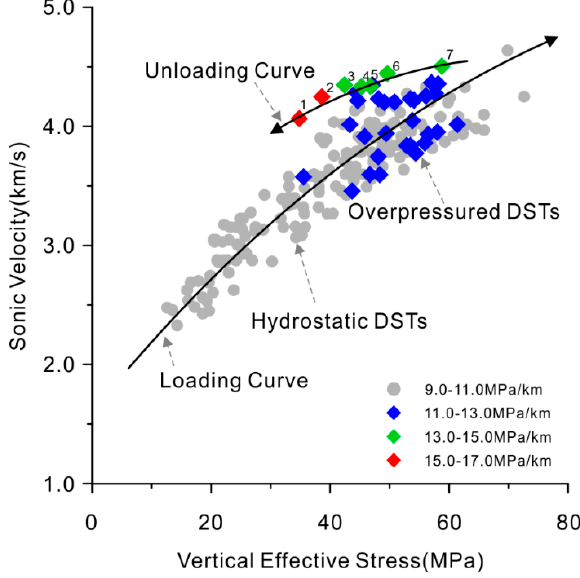
Figure 9. Acoustic velocity–vertical effective stress crossplots for the Linnan Sag. The points are on or near the loading curve, indicating normal compaction, or disequilibrium compaction (blue points), whereas the overpressured data lie on an unloading curve, suggesting that the overpressure is generated by fluid expansion or transfer processes (green and red points).